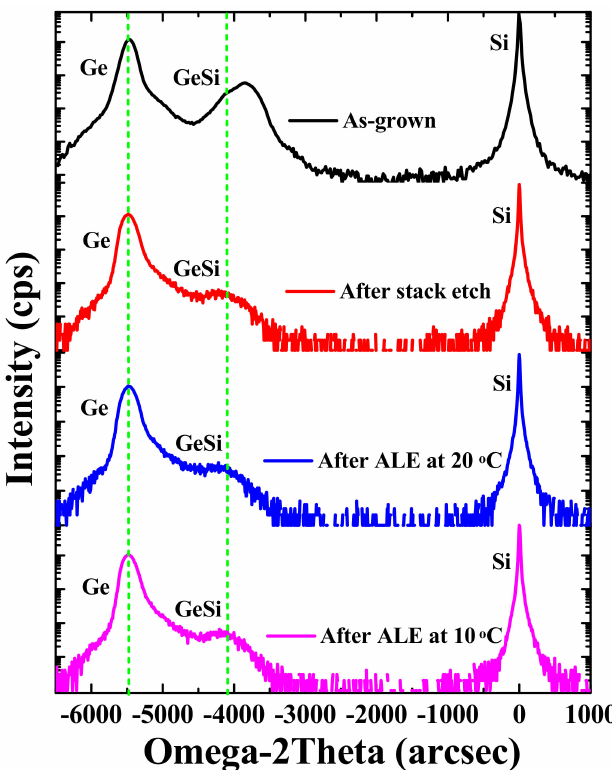
Figure 9. HRXRD rocking curves (RCs) around (004) reflection of stack samples of as-grown, after vertical stack etch, after ALE at 20 ◦ C, and after ALE at 10 ◦ C with 20 cycles.